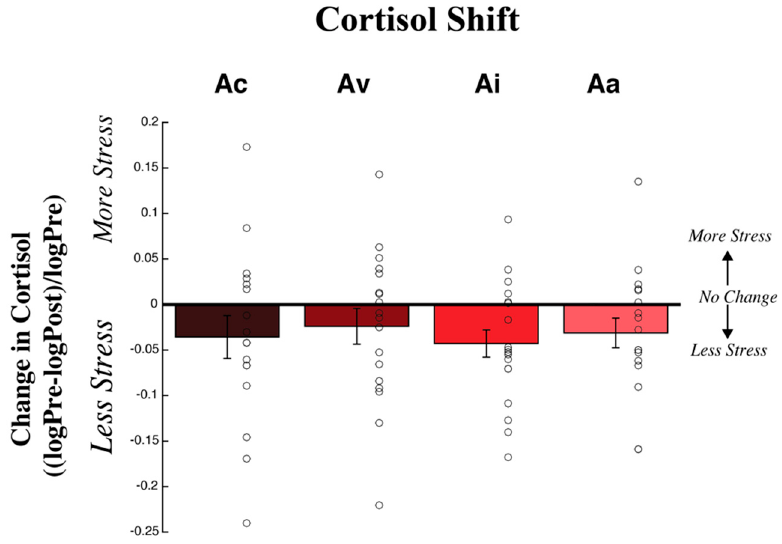
Figure 4. Cortisol Shifts.